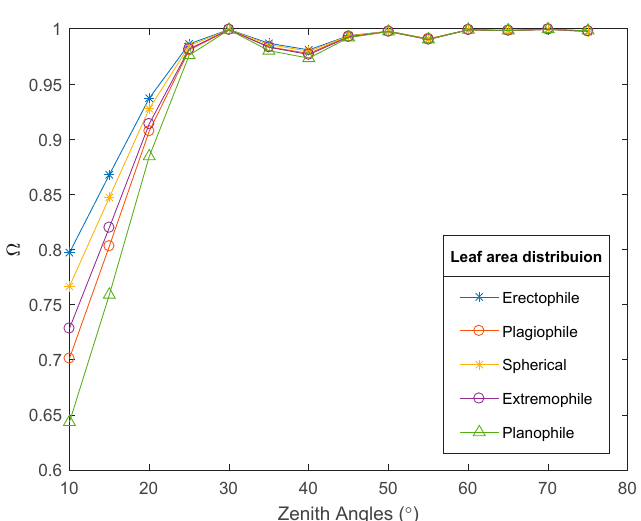
Figure 13. Leaf angle distribution effect for crop clumping index. Different curves refer to leaf angle distribution types (Erectophile, Plagiophile, Spherical, Extremophile, and Planophile). Simulation parameters: a 1 = 0.2, a 2 = 0.3, H = 1, r h g = 0.22, ρ 1 = 0.0999, T 1 = 0.1303.